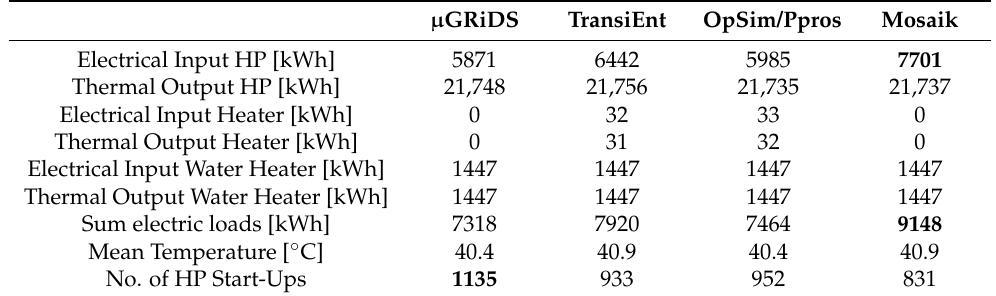
Table 8. Output indicators for the models under study. Significant deviations are